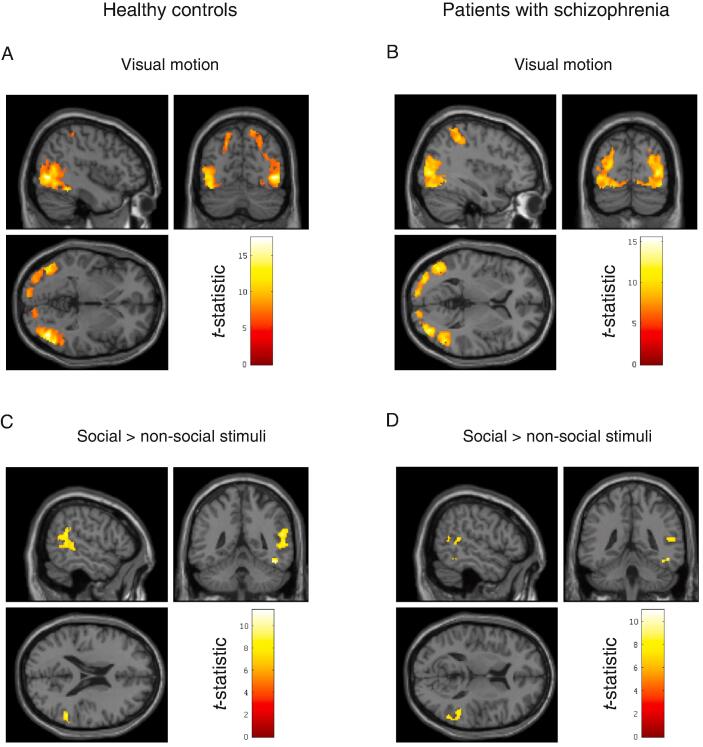
fMRI brain mapping in healthy controls and FES patients (A) Visual motion in healthy controls (B) Visual motion in patients with schizophrenia (C) Social > non-social stimuli in healthy controls (D) Social > non-social stimuli in patients with schizophrenia. Statistical t-maps are thresholded at p < 0.05, FWE-corrected for multiple comparisons and rendered on a single-subject structural MRI in MNI space. See main text for MNI coordinates.